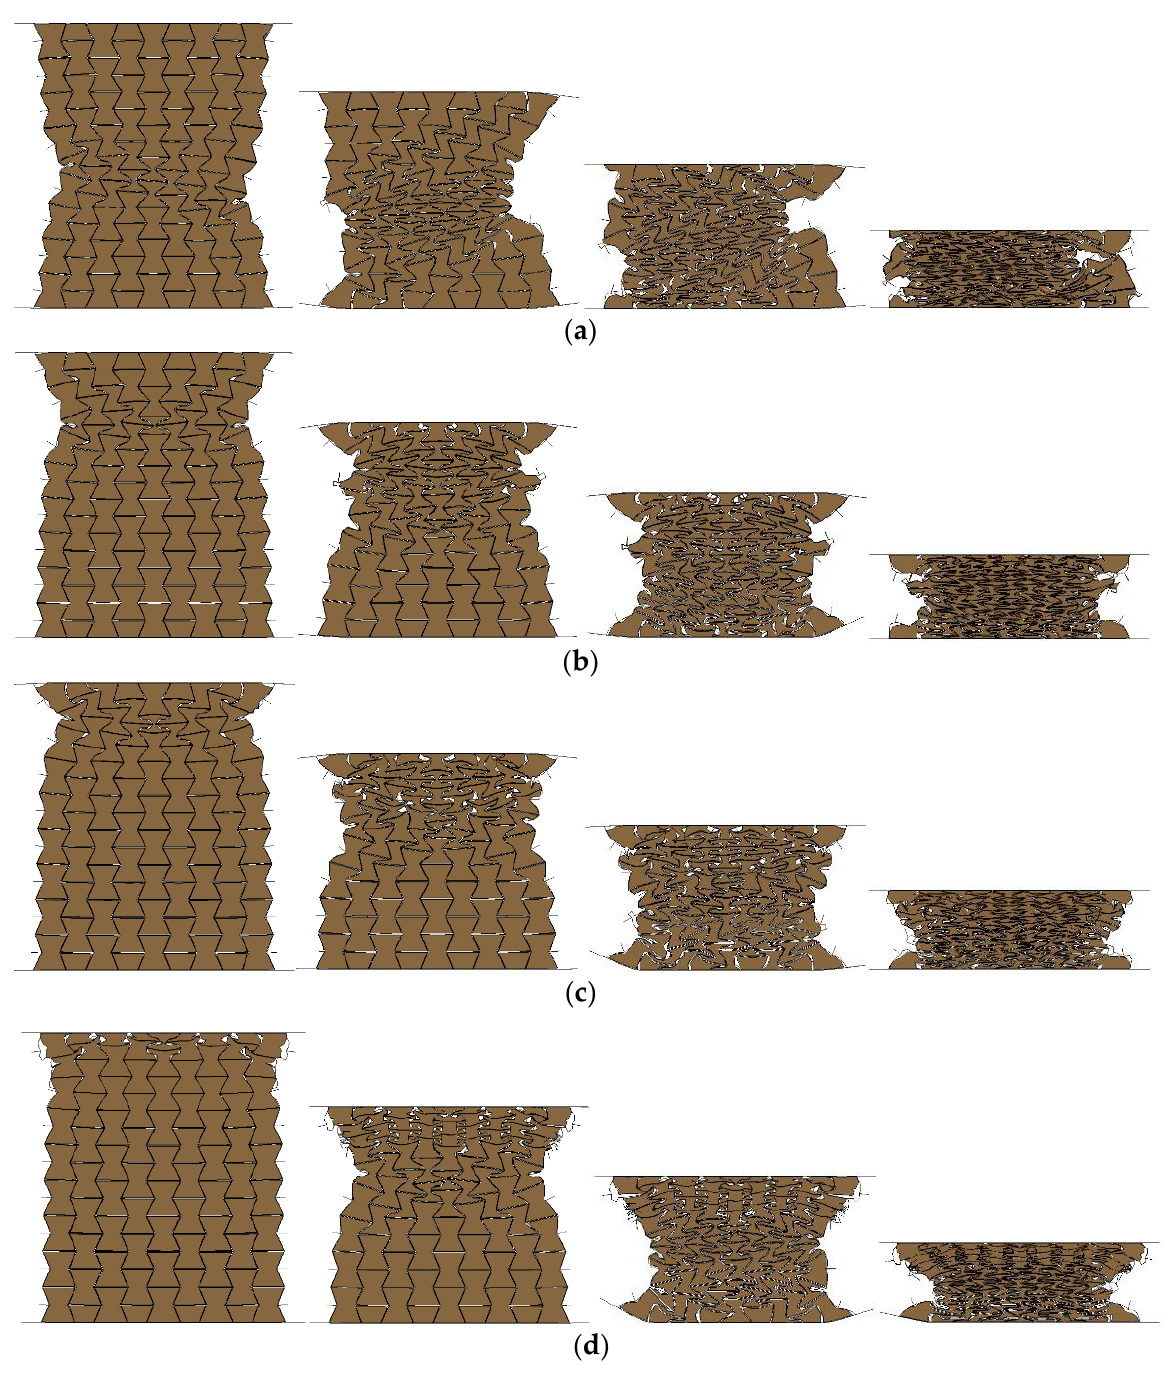
Figure 12. The response modes of foam concrete-filled auxetic honeycomb with different cell-wall thickness gradients at compression strokes of 15 mm, 45 mm, 75 mm, and 105 mm subjected to low-velocity impact (1 m/s): ( a ) AH-0; ( b ) PGAH-1; ( c ) PGAH-2; ( d ) PGAH-3.